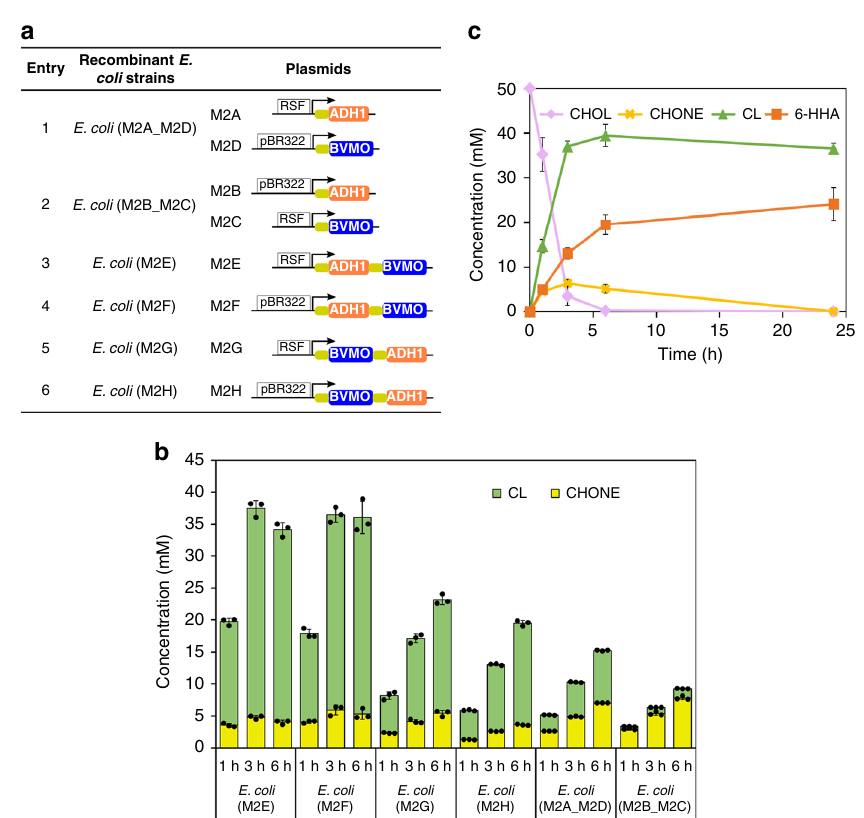
Fig. 4 Engineering of cell module 2 for conversion of CHOL 2b to CL 4b. a Construction of E. coli cells expressing alcohol dehydrogenase (ADH1) and Baeyer-Villiger monooxygenase with double mutation. See Supplementary Fig. 5 for SDS-PAGE of whole-cell proteins of module 2 expressed in E. coli . RSF: pRSFDuet-1; pBR322: pETDuet-1; arrow: T7 promoter. Orange fi lled rectangle: ADH1 gene; blue fi lled rectangle: BVMO gene. b Engineered E. coli cells containing enzymes of module 2 (ADH1 and BVMO) for the biotransformation of CHOL 2b to CL 4b . Green column: CL; yellow column: CHONE. c Time course of E. coli (M2E)-catalyzed transformation of CHOL 2b to CL 4b at substrate concentration 50 mM. Orange line: 6-HHA; green line: CL; yellow line: CHONE; purple line: CHOL. The data shown in b and c are presented as mean value ± SD (standard deviations) of three biological replicates. Source data are provided as a Source Data fi